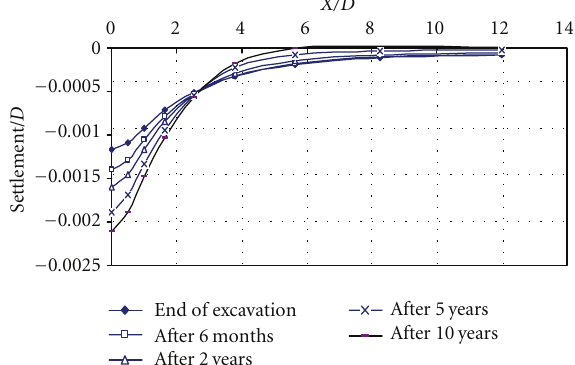
Figure 16: The surface settlement at di ff erent times using MCC soil model.